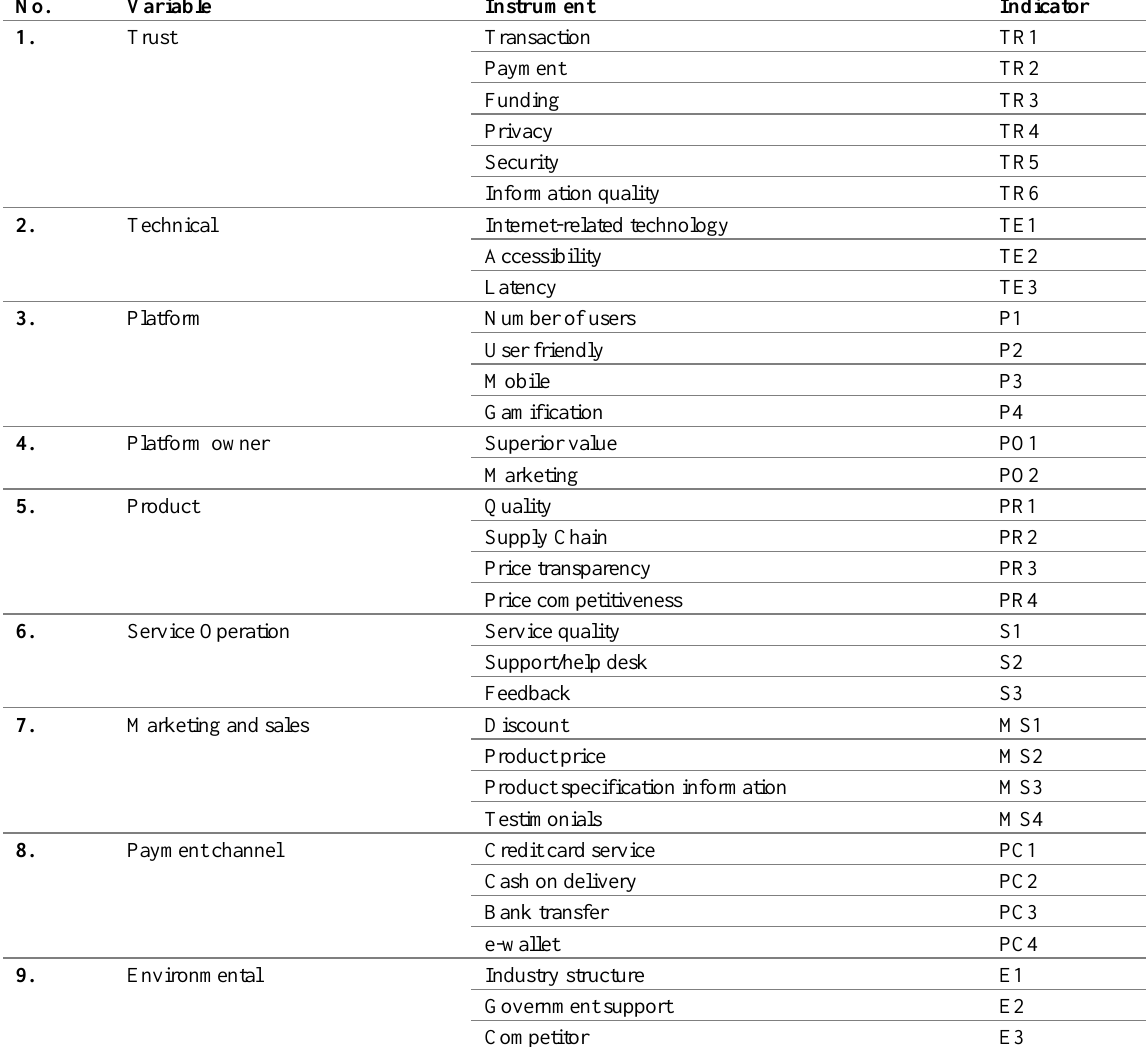
Table 1: Operational